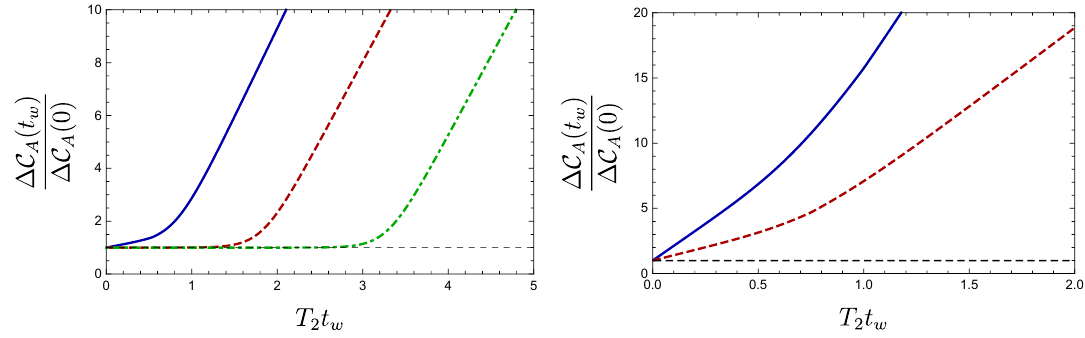
Figure 30. The complexity of formation for planar AdS 5 black hole (i.e., k = 0) as a function of the shock wave time t w . We normalize by the complexity of formation of the unperturbed black hole in eq. (B.16). In the left panel, we show (cid:1) ( t w ) for light shock waves with w = 1 + 10 (cid:0) 1 C A (solid blue), w = 1+10 (cid:0) 4 (dashed red) and w = 1+10 (cid:0) 8 (green dot-dashed). For very light shocks, the complexity of formation remains close to the unperturbed value until times of the order of t (cid:3) , scr then increases approximately linearly with t w . In the right panel, we show (cid:1) ( t w ) for heavier C A shock waves, with w = 2 (solid blue) and w = 1 : 5 (dashed red). In these cases, the complexity of formation begins growing immediately as t w moves away from